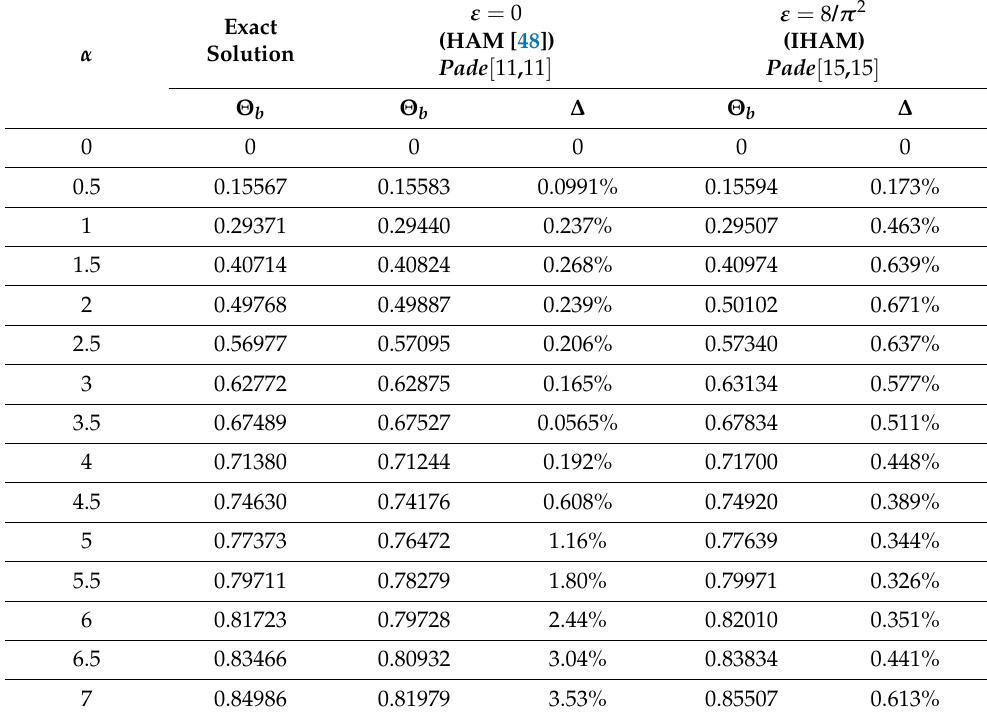
[ P ] by IHAM and b